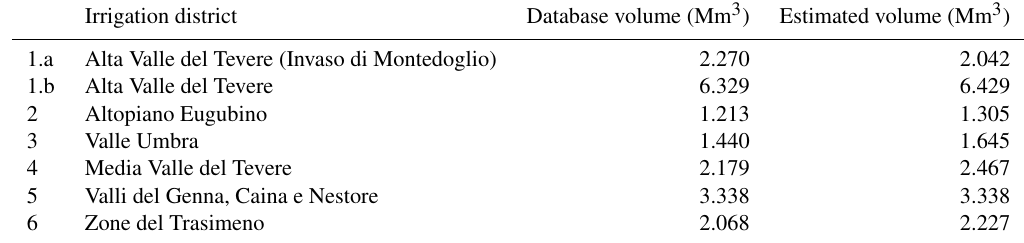
Table 3. Comparison between database and estimated volumes by volume–area relationships at irrigation district level. Irrigation district